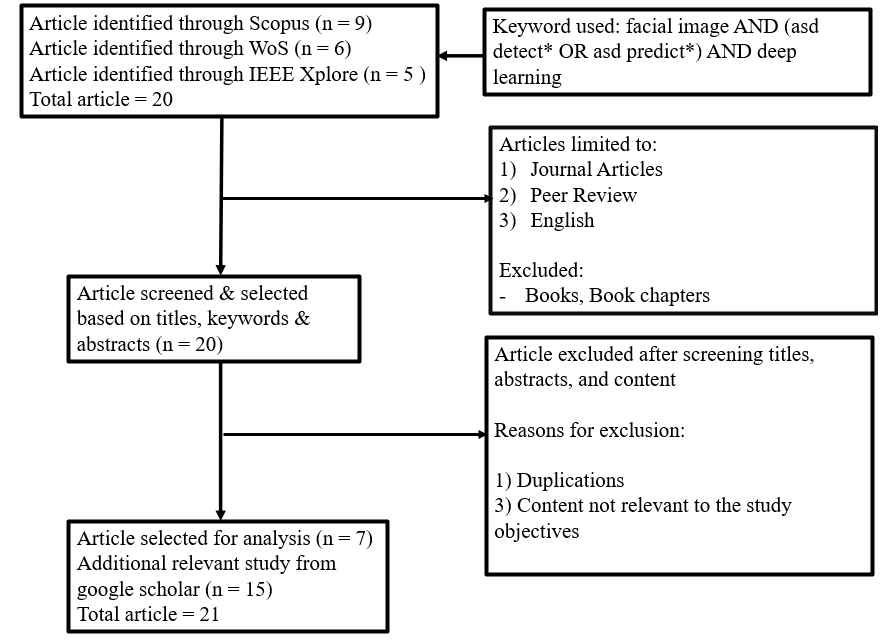
Figure 1. Flow diagram of the ASD article selection procedure for ablation